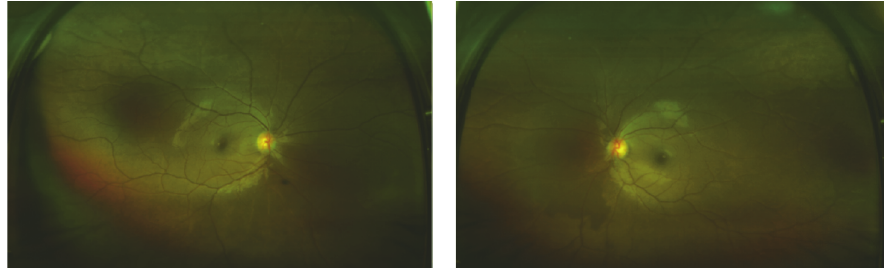
Figure 1: Ultra-wide-field fundus photographs of a patient with microscopic polyangiitis showing relatively normal appearing retinas in both eyes.